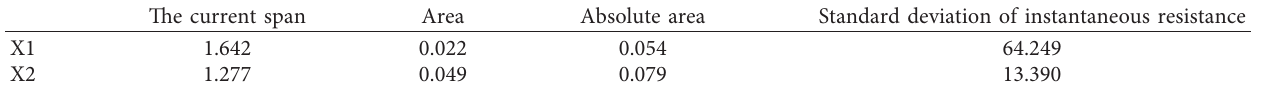
Table 6: The V-I trajectory characteristics of gear 1 of the device.